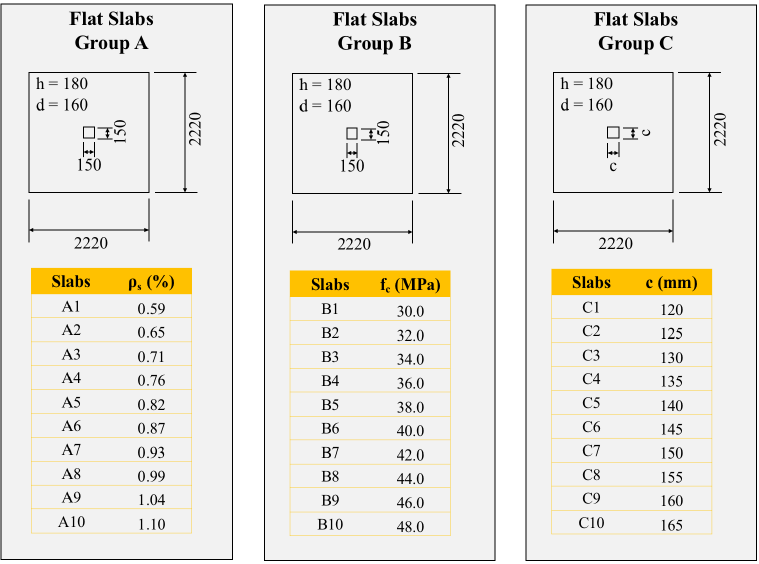
Figure 6. Slabs from groups A, B and C.